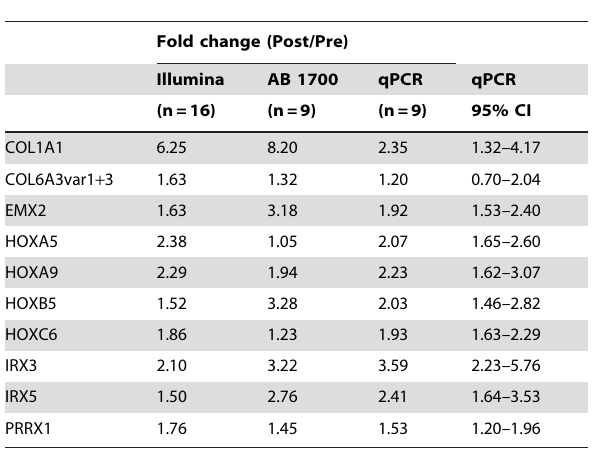
Table 6. Up-regulated genes in adipose tissue of lean healthy controls versus post-surgery subjects (Oxidoreductase, q-value= 0).